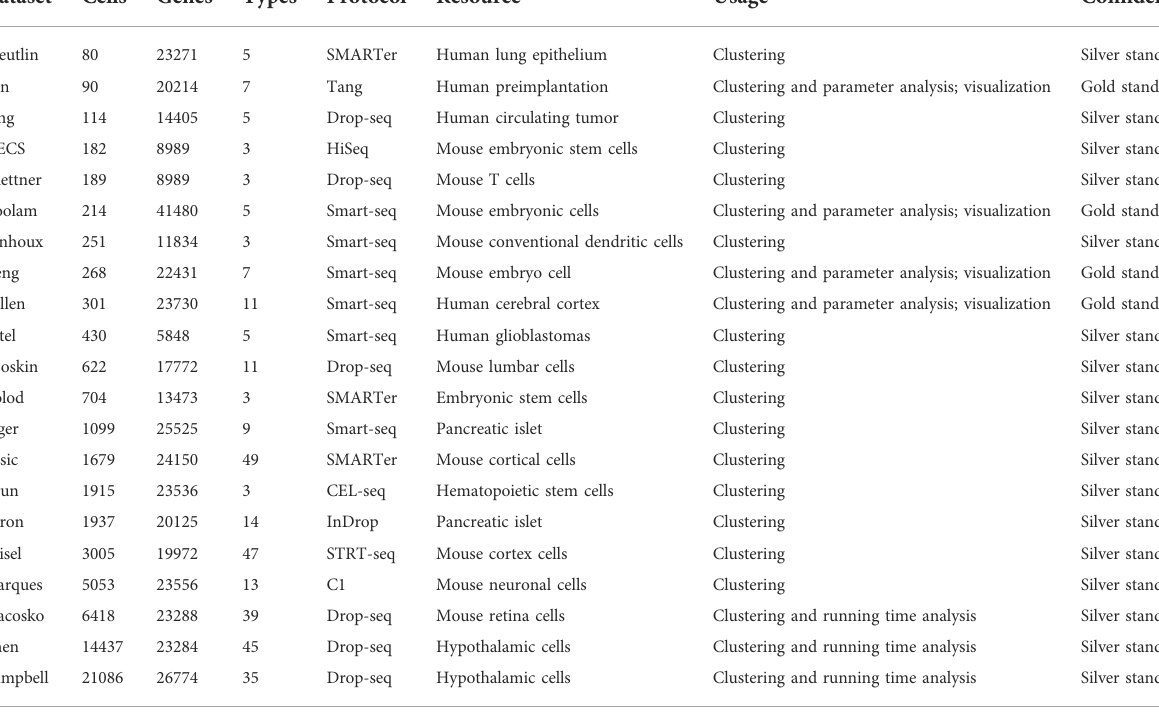
TABLE 1 Summary of the 21 real single-cell RNA-seq datasets. Dataset